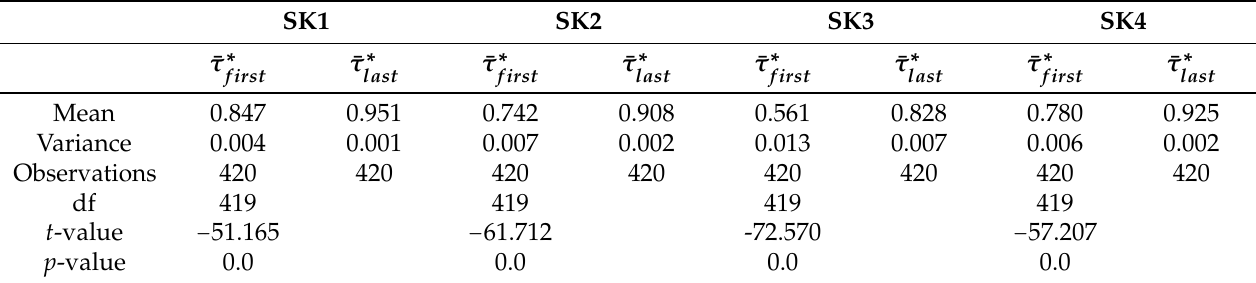
Table 4. Average of the computed collective concordance indices per category ( m = 3). SK1 SK2 SK3